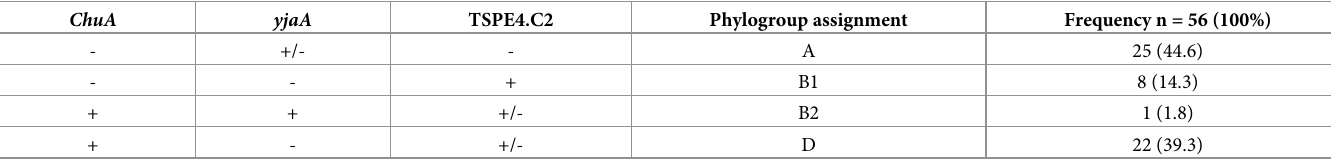
Table 1. Phylogenetic groups of the APEC suspect isolates. ChuA